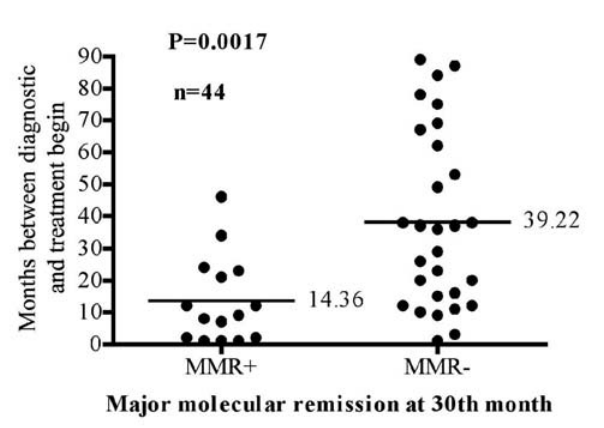
Figure 3 - Months between diagnosis and initiation of treatment, according to major molecular remission (MMR) status after 30 months of